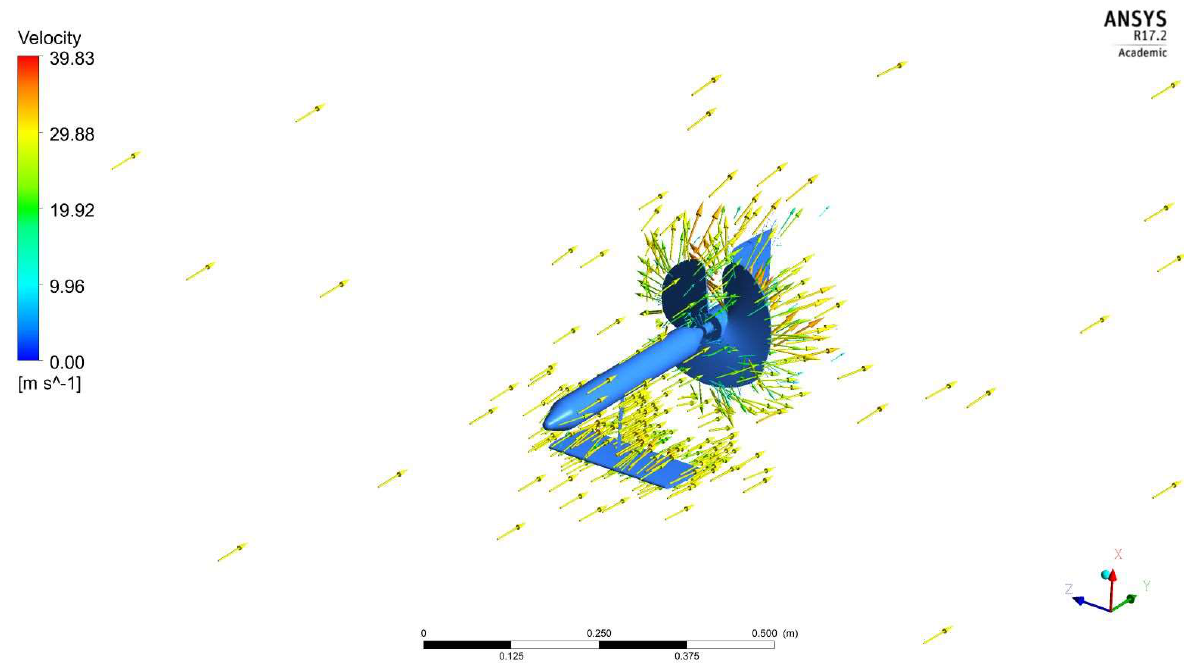
Figure 36. An isometric projection of velocity variations on advanced US with horizontal fins—high speed altitude increment operation.